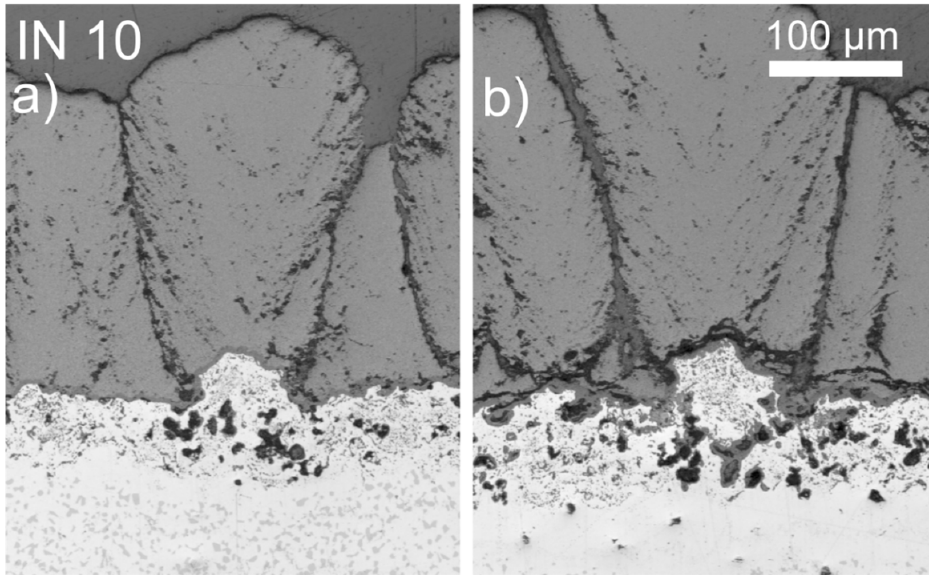
Figure 5. Laser-microscope images of TBC systems using columnar yttria-stabilized zirconia SPS top coat, Co-based alumina-oxide-dispersion-strengthened bond coat (10% alumina) and conventional bond coat (on Inconel 738 substrate–not visible) indicating porosity to the column attachment ( a ) and a single detached column ( b ).